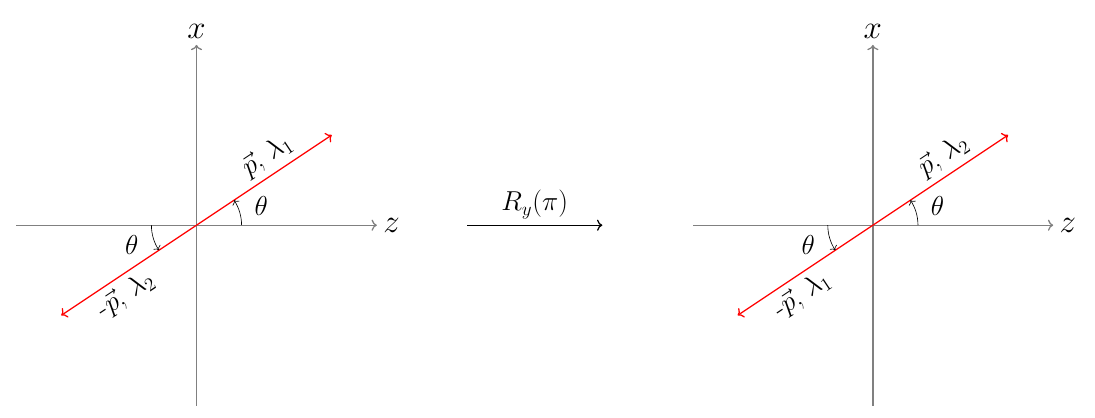
Figure 9 . The geometric picture behind (C.8). The particles are identical and are therefore represented by the same